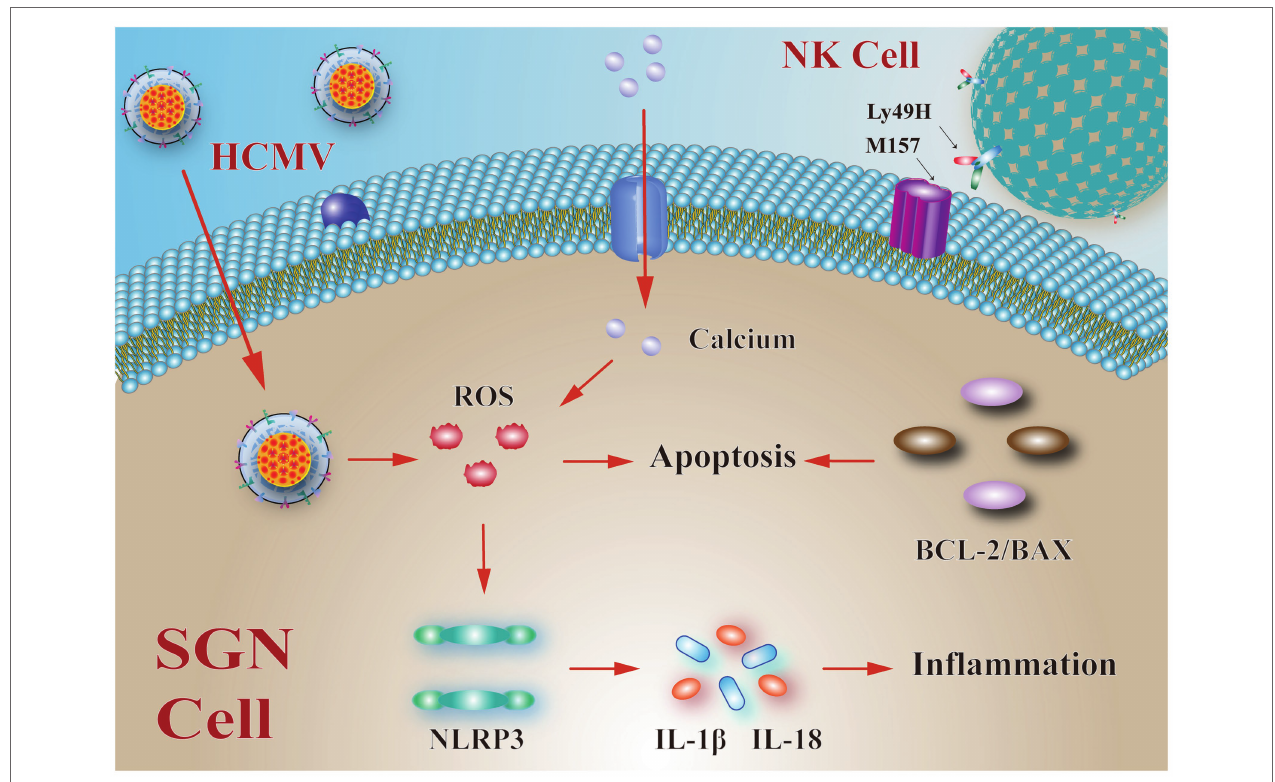
FIGURE 1 | Possible mechanisms and pathways of human cytomegalovirus (HCMV) infection in spiral ganglion neurons (SGN) cells. The mechanism of sensorineural hearing loss (SNHL) may be related to the apoptosis of SGN cells. The HCMV infection can increase reactive oxygen species (ROS) levels, activate nucleotide-binding oligomerization domain-like receptor protein 3 (NLRP3) inflammatory bodies in cochlear and SGN, and activate Caspase 1 to increase the maturation and release of IL-1 beta and IL-18, thus leading to inflammatory responses. Continuous increase in Ca 2+ also causes an increase in ROS. Bcl-2 and Bax are also involved in the apoptosis of SGN cells. Also, the interaction between LY49H on the surface of NK cells and M157 expressed by HCMV is associated with the apoptosis of